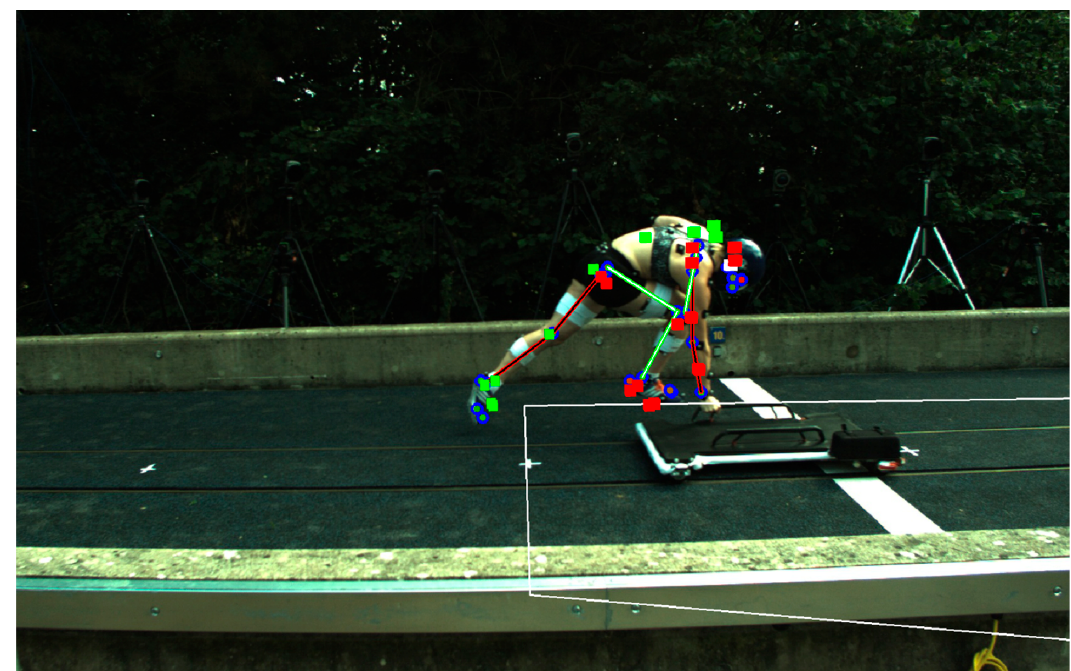
Figure A4. OpenPose keypoint detection examples depicting pose estimation during pushing. Blue circles depict the 2D OpenPose keypoint locations with the circle fill colour representing the left (green) and right (red) sides of the body. Cubes depict the 3D reconstructed joint centres for the left (green) and right (red) sides of the body projected onto the 2D image plane. This example demonstrates that limb switching has occurred for the legs but this has largely been corrected during the 3D fusion process. However, further issues can been seen with the left arm where OpenPose has detected joint centres with limited success in multiple fields of view.